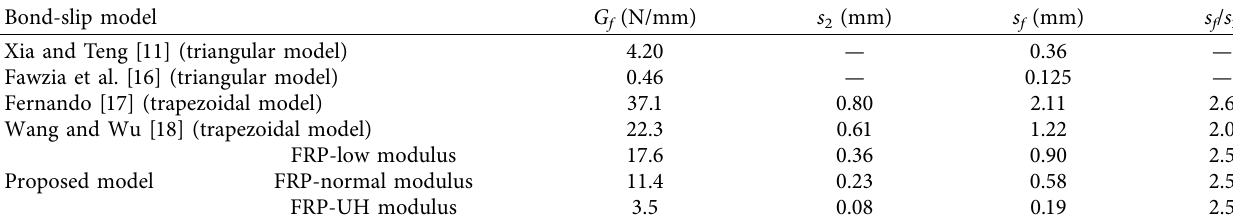
Table 3: Calibrated bond-slip parameters for proposed model and previous ones.